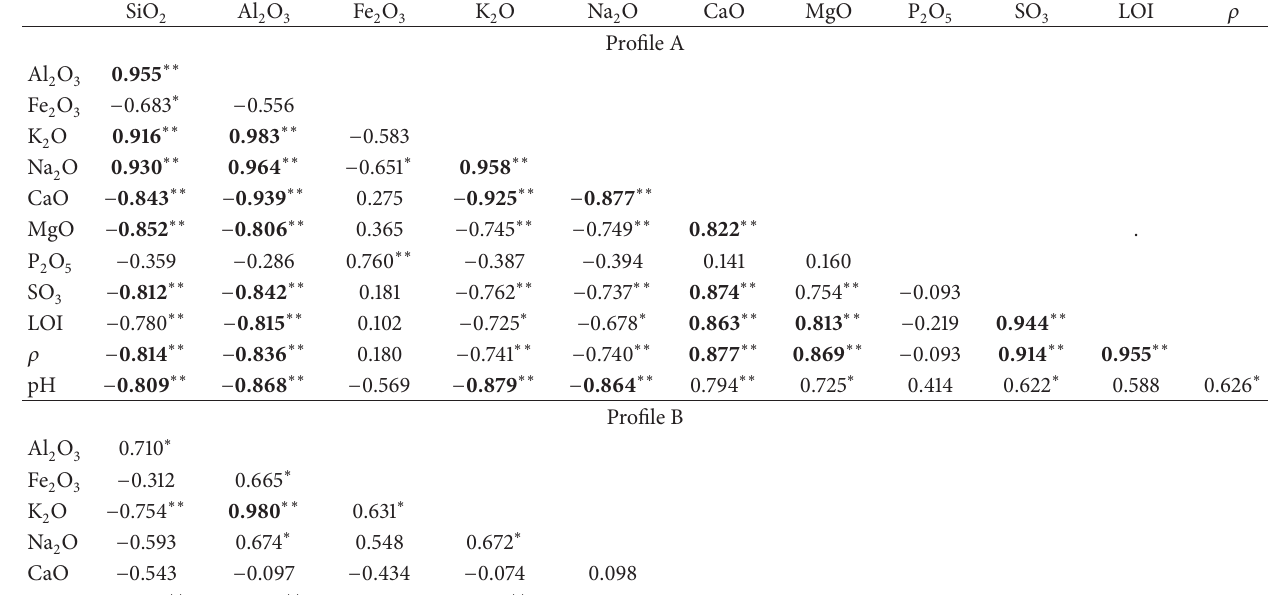
Table 2: Pearson correlation coefficients among major elements, density, and pH value for the profiles A, B, and C, respectively. Values greater than 0.80 are indicated in